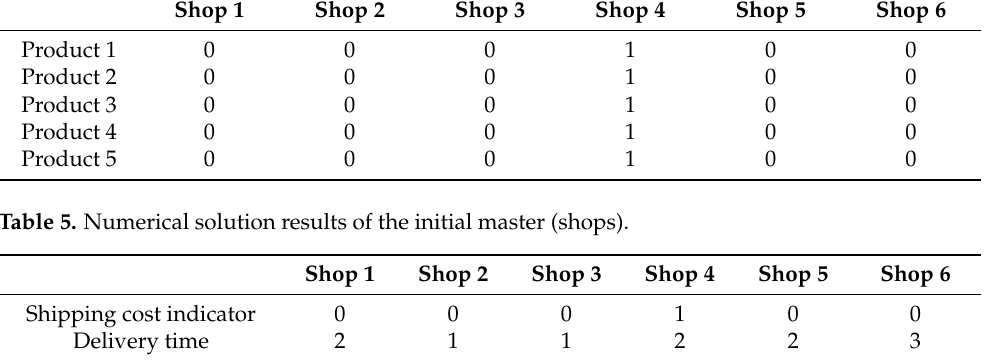
Table 4. Numerical solution results of the initial master (products). Shop 1